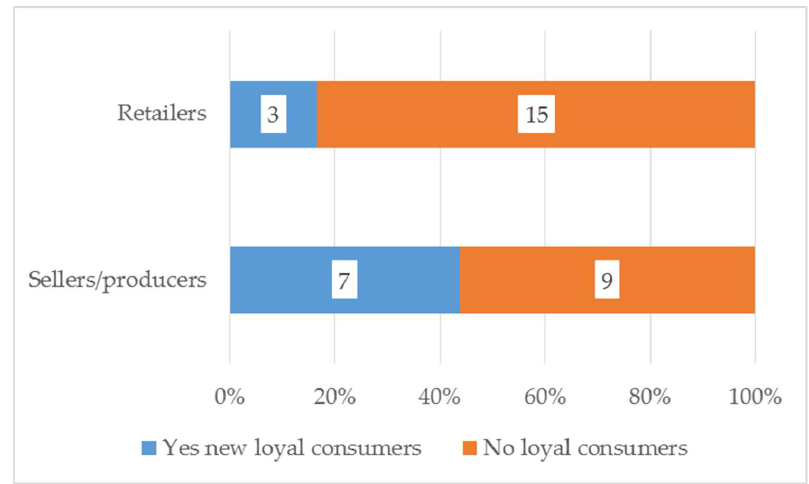
Figure 6. New loyal consumers %. Source: The authors.